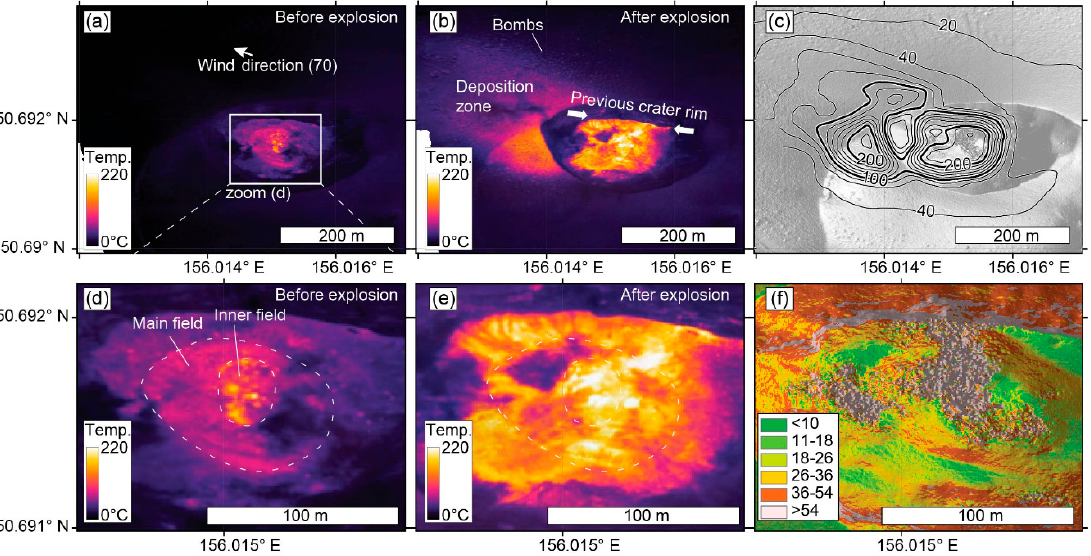
Figure 6. New North Crater before and after the 23:40 event on 13 July 2019 recorded by a UAS thermal camera. ( a ) Before the eruption, the thermal infrared orthomosaic shows main temperature zones. The enlarged crater area (panel d) is indicated by a white rectangle. Note that the data are the same as in Figure 3c but with different color scales to allow comparison to UAS data after the explosion. ( b ) After the eruption, the temperature increased inside the active crater but also on the western flank, indicating the deposition zone. Enlarged area (panel e). ( c ) Temperature isolines (interval 20 °C) derived from data shown in panel b. ( d–f ) Enlarged inner crater. ( f ) Slope map calculated by the gradient of the digital terrain model, revealing structures aligned along the previous crater rim.